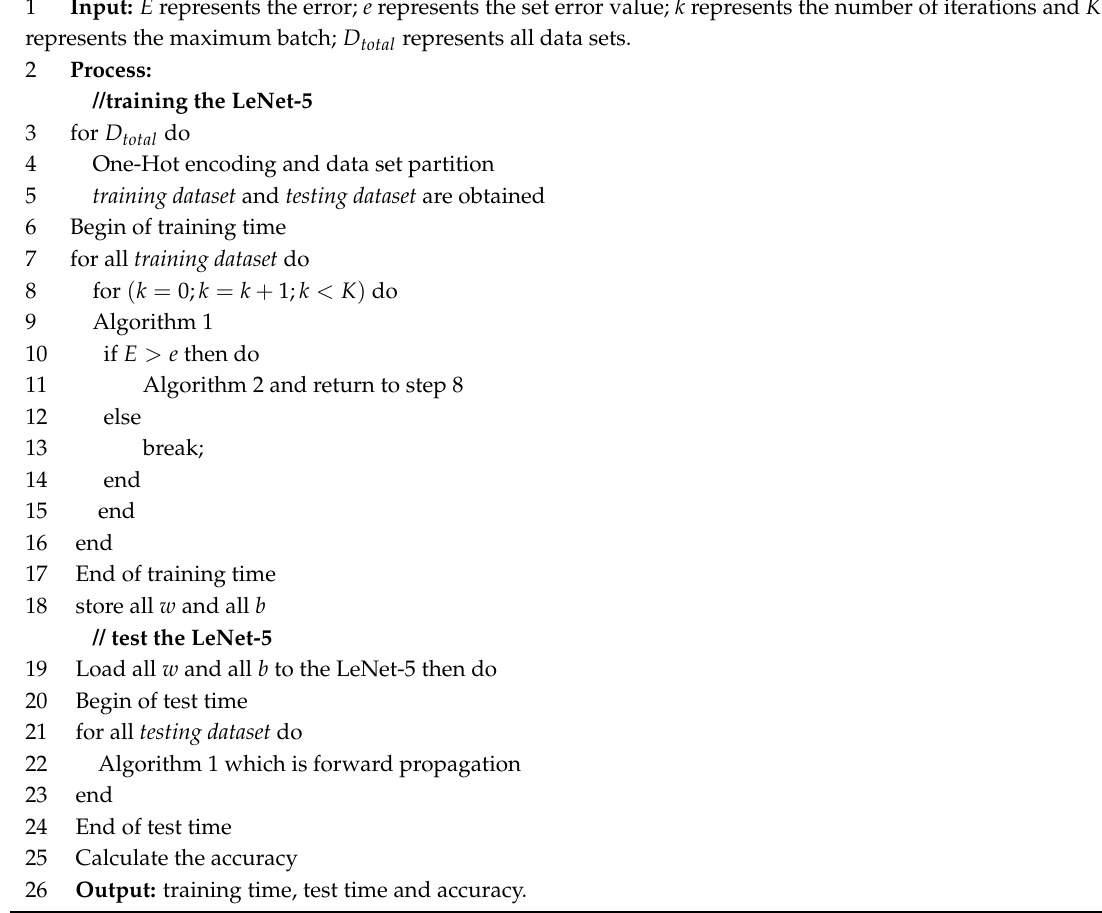
Algorithm 3 The gas recognition algorithm based on